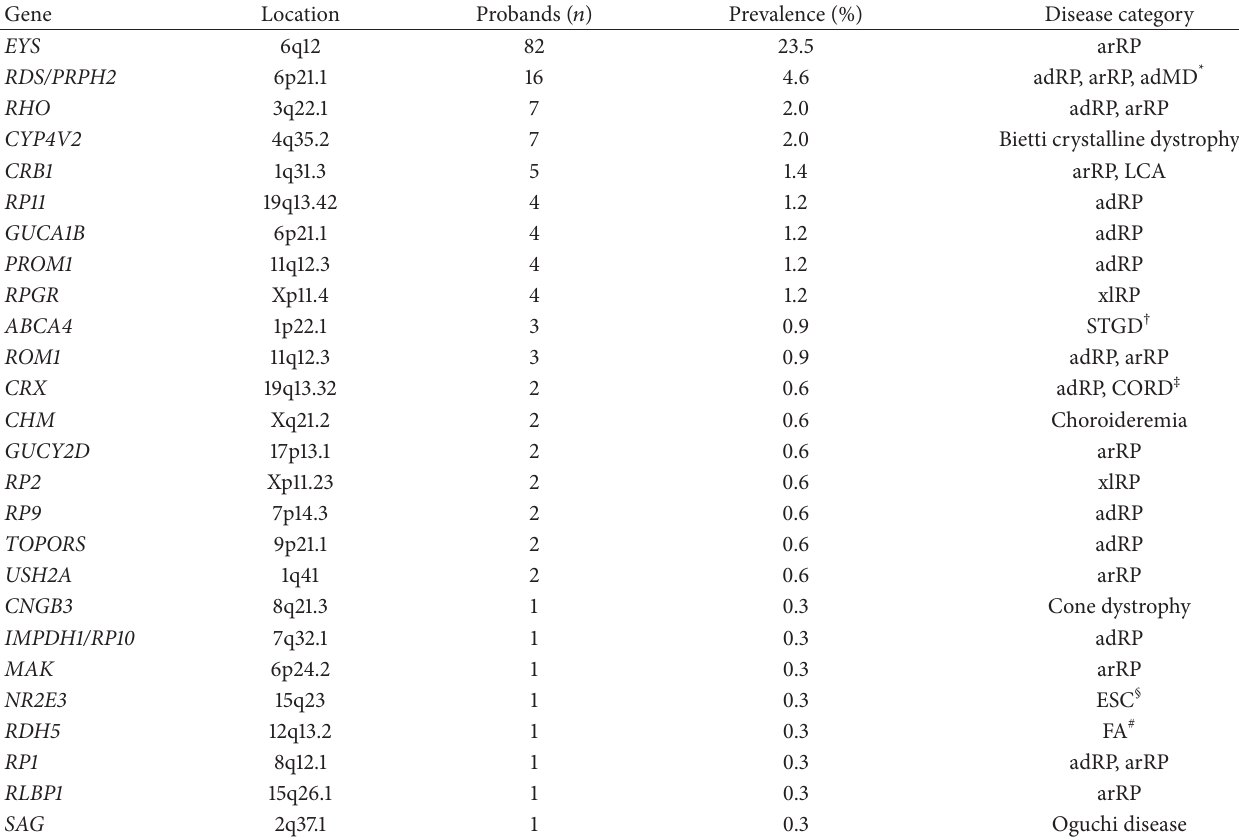
Table 2: Prevalence of mutations among 349 probands in this